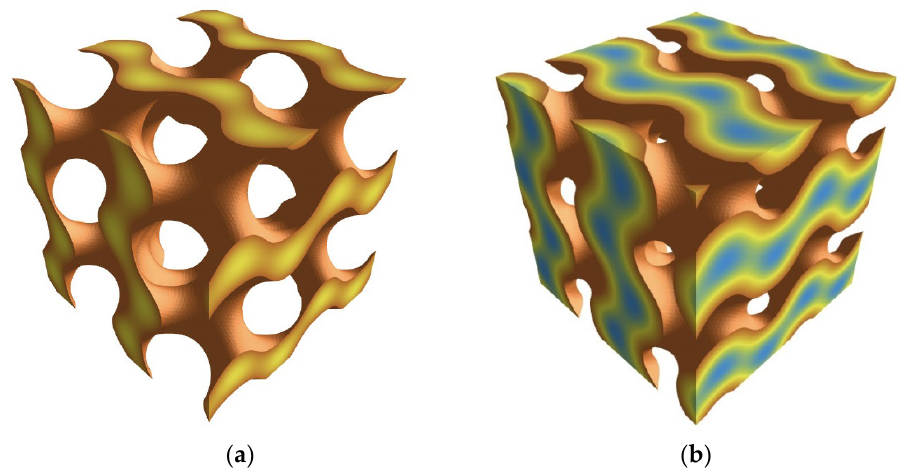
Figure 1. Three-dimensional model of a bicontinuous double gyroid phase of a wedge-shaped amphiphile in a dry ( a ) and swollen ( b ) state. Yellow chocolate color indicates the hydrophilic part of amphiphilic molecules, while the blue color denotes the water inside the molecular channels. The structure in ( b ) contains water fraction 33 wt.%.